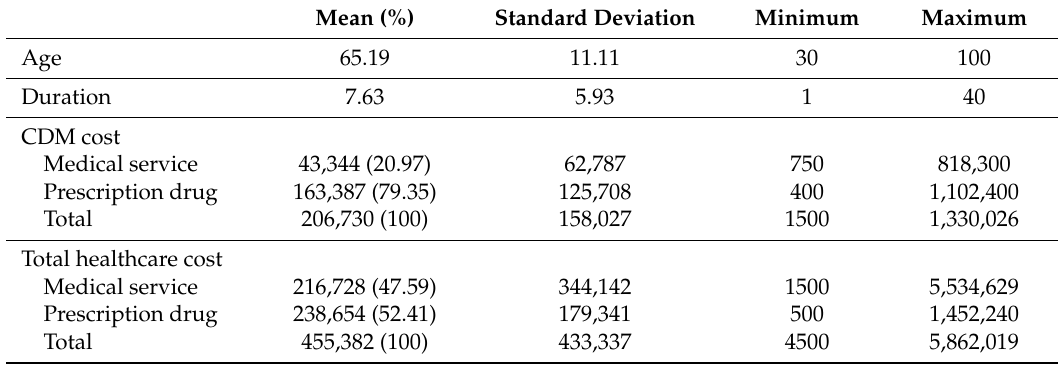
Table 2. Summarization of patient’s age, duration of diseases, and annual healthcare costs, 2012 (N = 1481).